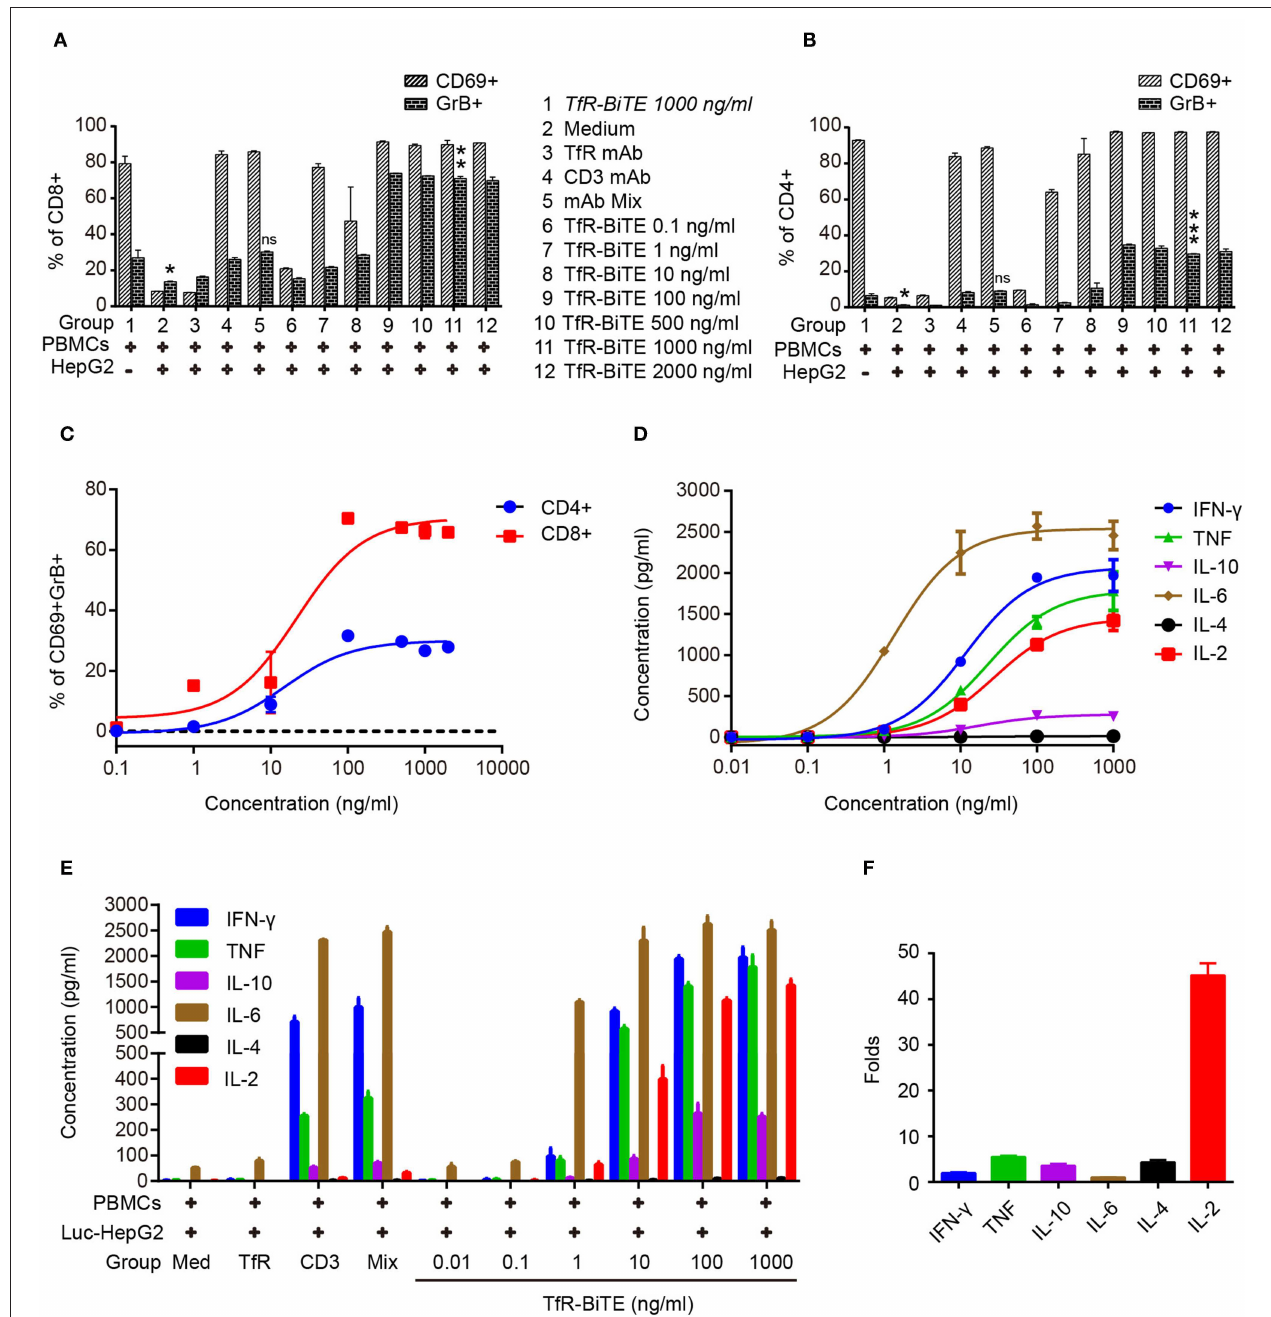
FIGURE 4 | TfR-BiTE induces T-cell activation. HepG2 cells and PBMCs were incubated with various concentrations of TfR-BiTE for 24h. E:T ratio was 10:1. T-cell activation markers as CD69 + , GrB + were, respectively, measured and calculated in CD8 + (A) and CD4 + (B) subsets. The significance shown in the figure is compared with group 1 (TfR-BiTE 1,000ng/ml, Italic). CD69 + GrB + double positive T subsets were analyzed in (C) . Cytokine profile released by PBMCs treated with TfR-BiTE (D) or control antibodies (E) for 48h. (F) Folds of cytokine released (1,000ng/ml TfR-BiTE group vs. mAb Mix group). Assays were done either in triplicate with average, and SD value plotted or as single-dose response curve representative of multiple assays of different donors. ns, not significant; * p < 0.05; ** p < 0.01; *** p <